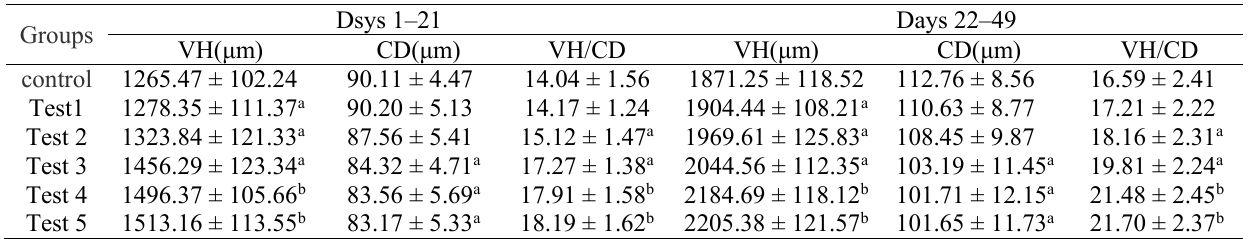
Effects of Clostridium butyricum on VH, CD and VH/CD value of broilers (n = 6)